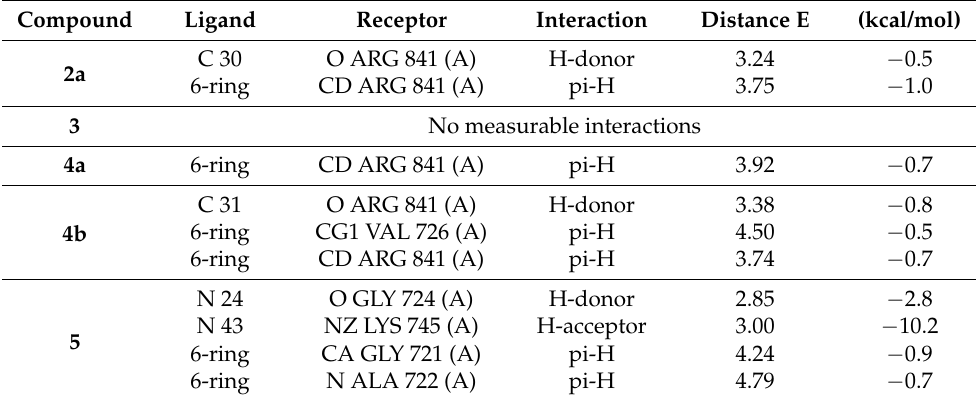
Table 8. Docking interaction of all compounds with ovarian “ 3 W2S ”